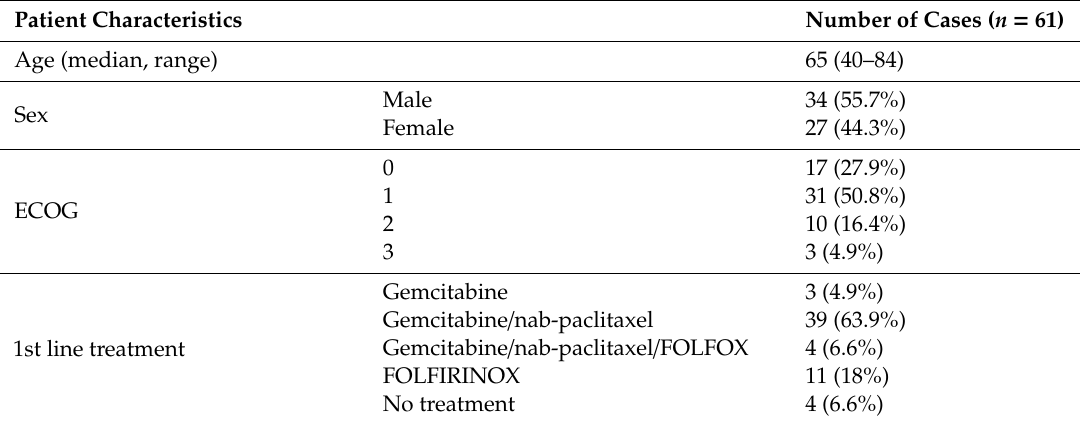
Table 1. Baseline characteristics of